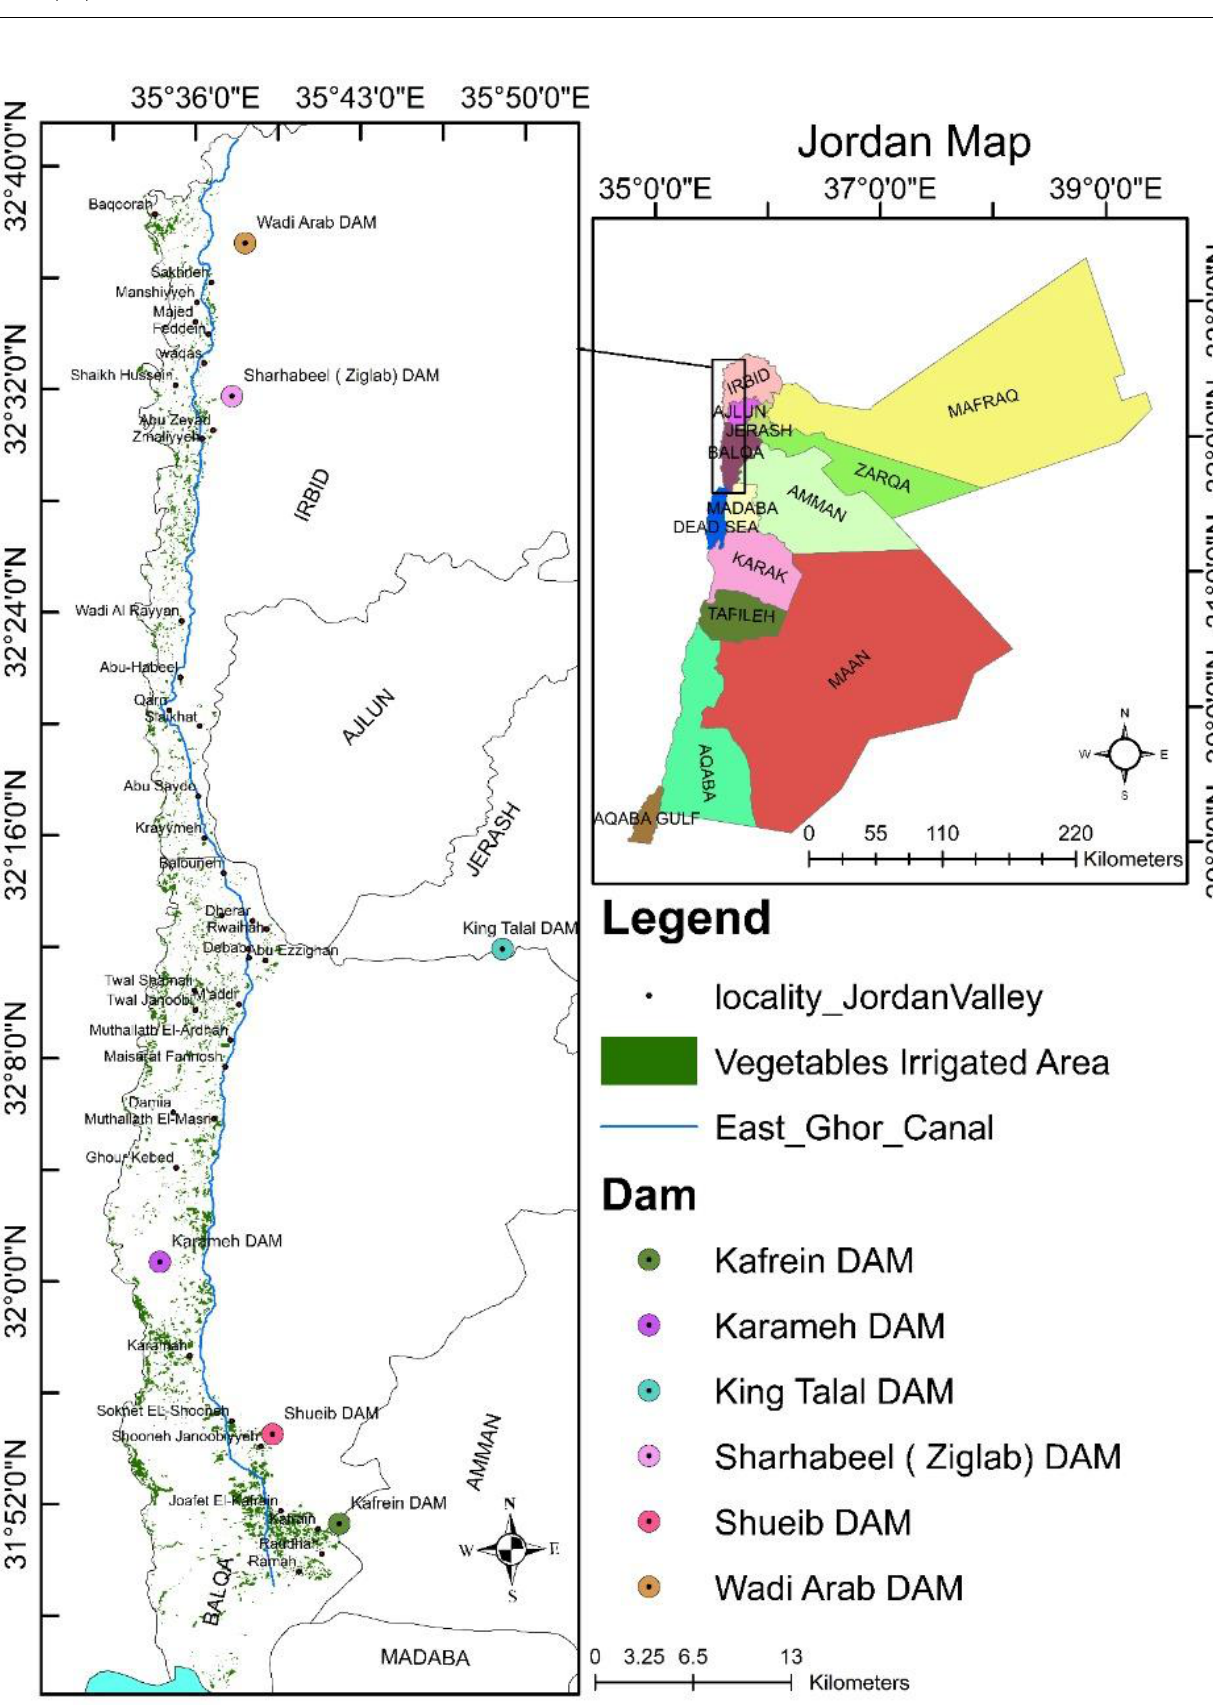
Figure 1. Geographical location of the study area.